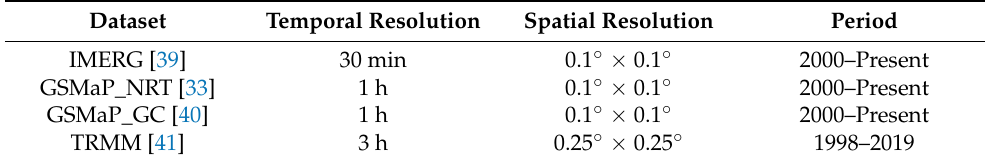
Table 1. List of satellite rainfall data used in the present study. Dataset Temporal